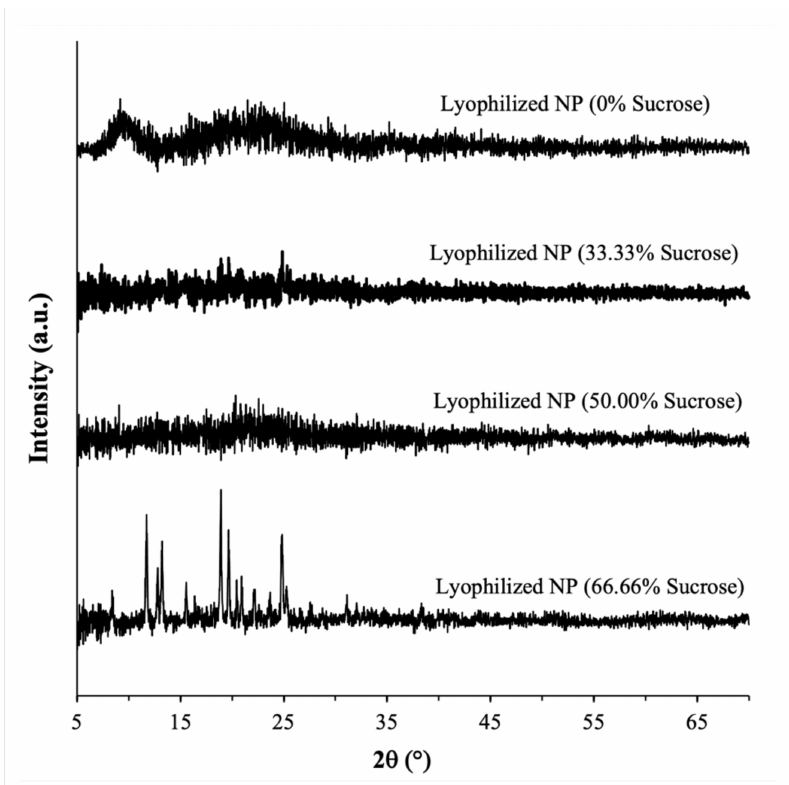
Figure 5. PXRD patterns of the lyophilized CUR-BSA nanoplexes prepared at different sucrose mass fractions after 30-day exposures at 40 ◦ C and 75%